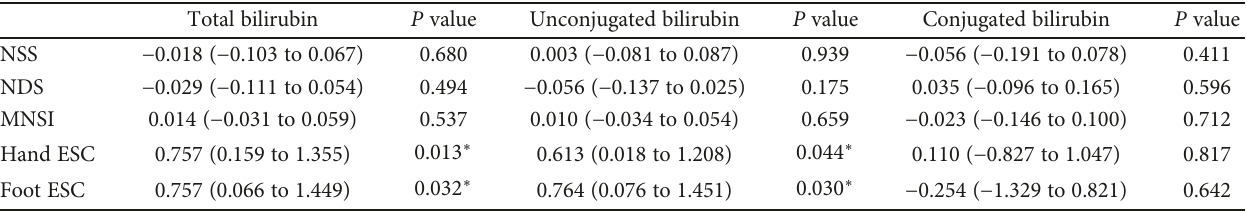
Table 4: Multiple linear regression analysis of association between bilirubin level and NSS, NDS, and MNSI scores and ESC levels detected by the SUDOSCAN.